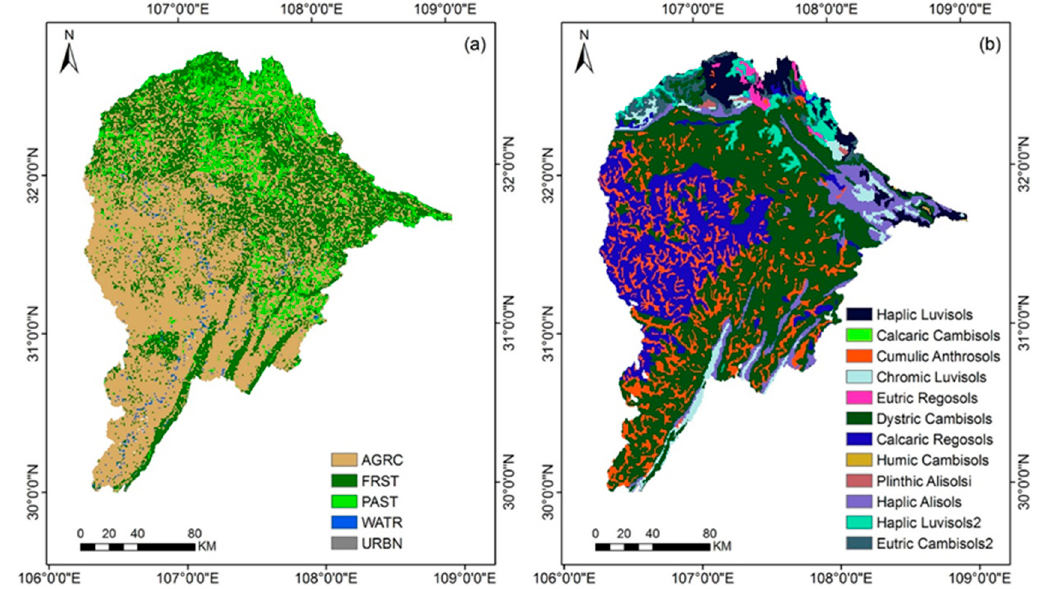
Figure 2. Spatial attribute distribution of the Qujiang River basin: ( a ) land use cover and ( b ) soil types.